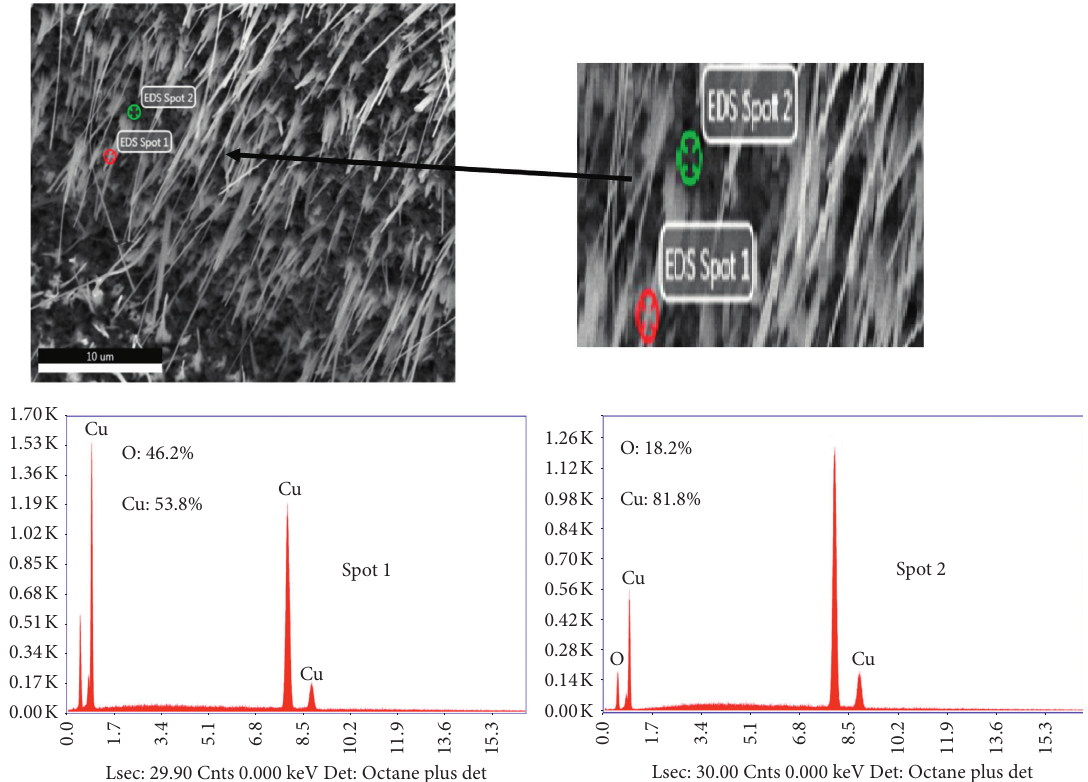
Figure 4: EDX analysis for the sample obtained by heating at 10 ° C/min. Spot 1: the NW contains the CuO lattice. Spot 2: the nucleation site base may contain CuO, Cu 2 O, and Cu lattices.